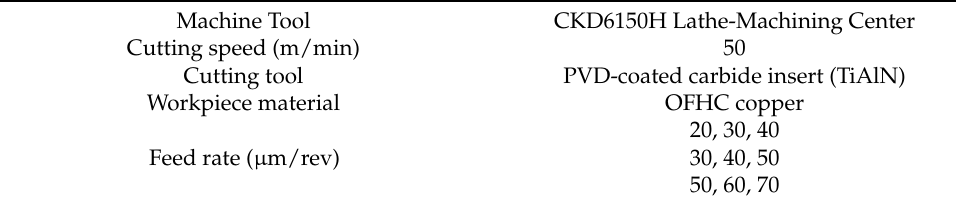
Table 1. The parameters of micro-cutting.